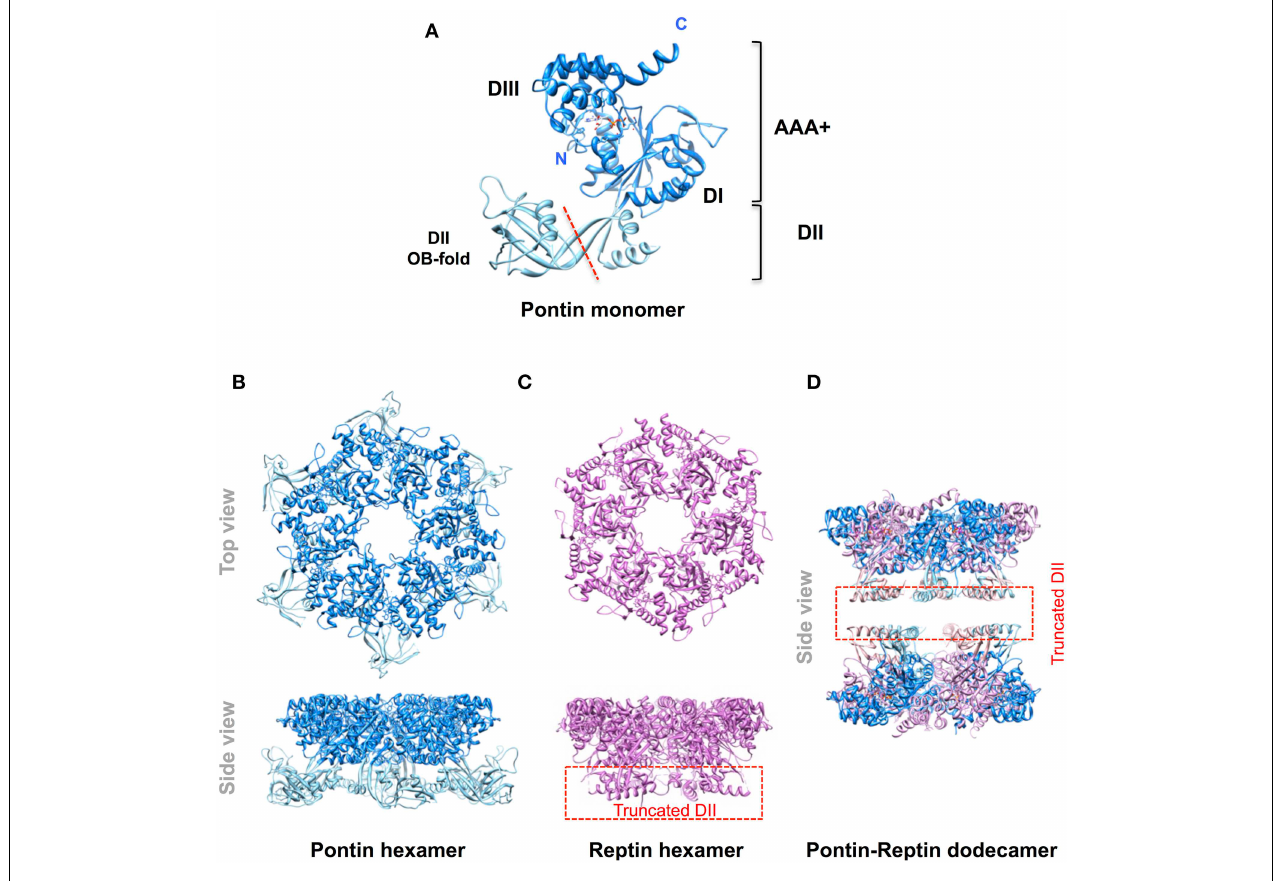
dodecamer (PDB 2XSZ, Gorynia et al., 2011). In (C,D) the domain II region to the left of the red dashed line in (A) was truncated to